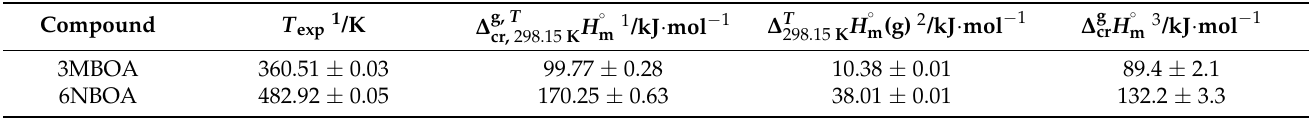
Table 2. Standard ( p ◦ = 0.1 MPa) molar enthalpies of sublimation, ∆ g cr H ◦ m , at T = 298.15 K, determined by Calvet microcalorimetry for the compounds